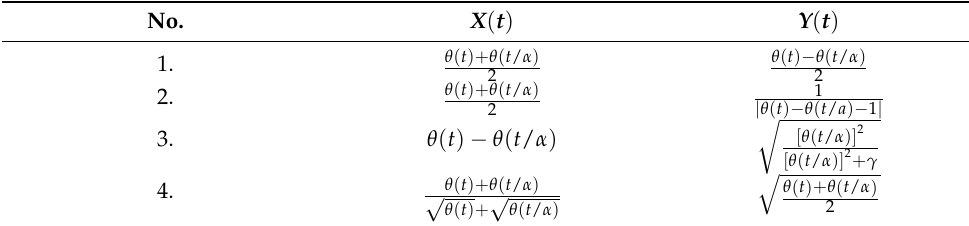
Table 1. Examples of identification